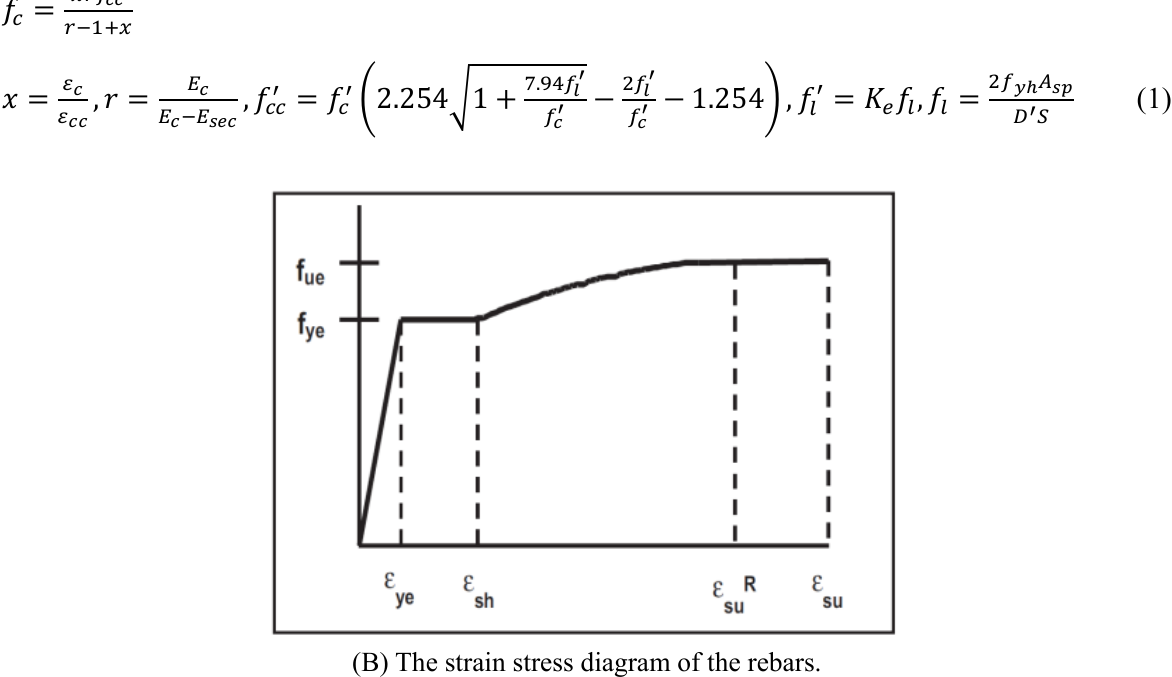
(B) The strain stress diagram of the rebars. Fig. 3. Stress-strain diagram